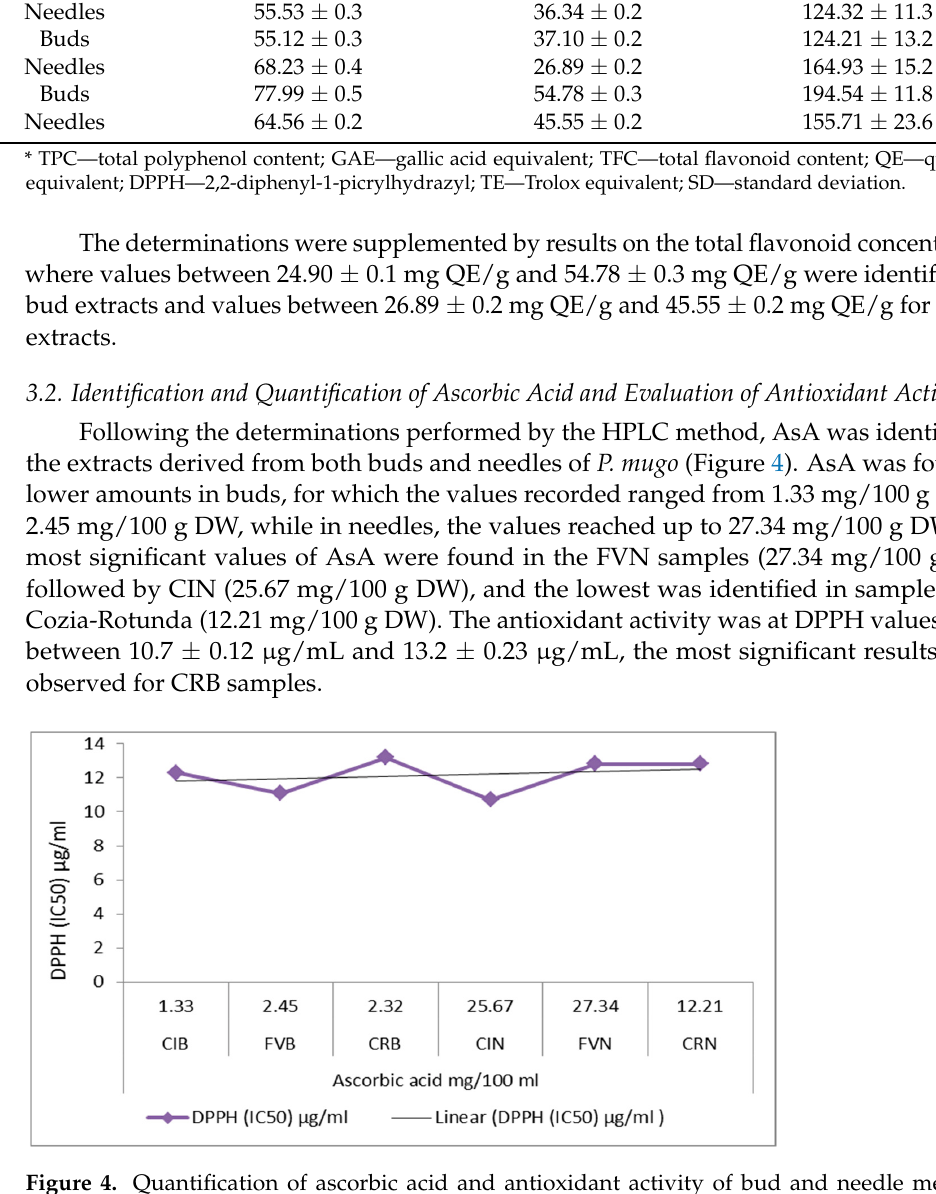
Table 3. Total polyphenols and flavonoids in bud and needle methanol extracts of Pinus mugo harvested from the mountainous areas Cindrel-Iujbea, F ă g ă ras